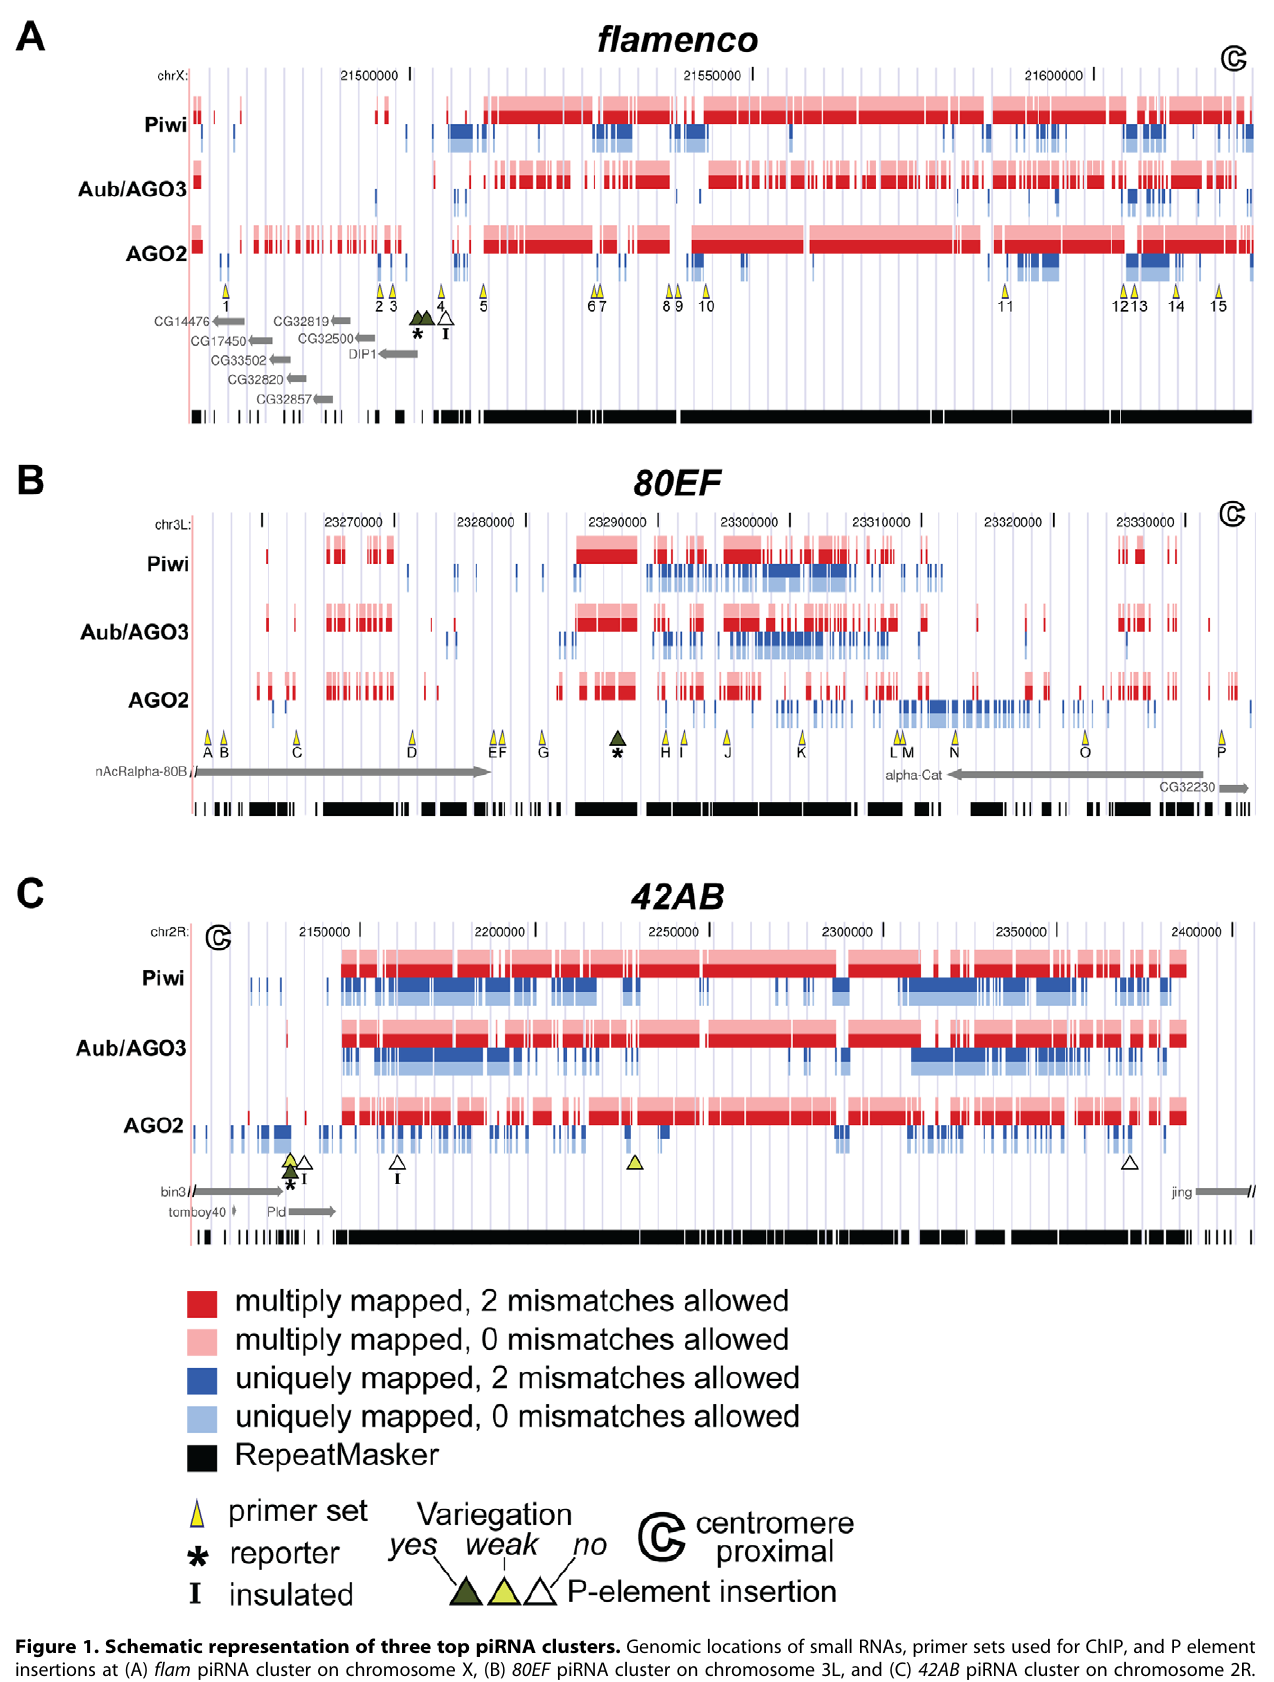
Figure 1. Schematic representation of three top piRNA clusters. Genomic locations of small RNAs, primer sets used for ChIP, and P element insertions at (A) flam piRNA cluster on chromosome X, (B) 80EF piRNA cluster on chromosome 3L, and (C) 42AB piRNA cluster on chromosome 2R. Sequence datasets derived from previous studies were mapped to the genome using Bowtie software allowing two or zero mismatches [57]. Piwi-